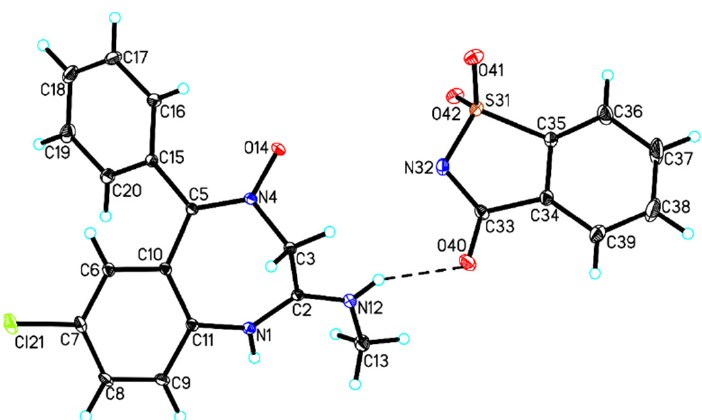
Figure 3. Molecular structure of saccharin salt of chlordiazepoxide showing the atom-labeling scheme (hydrogen bonds are represented by dashed lines).